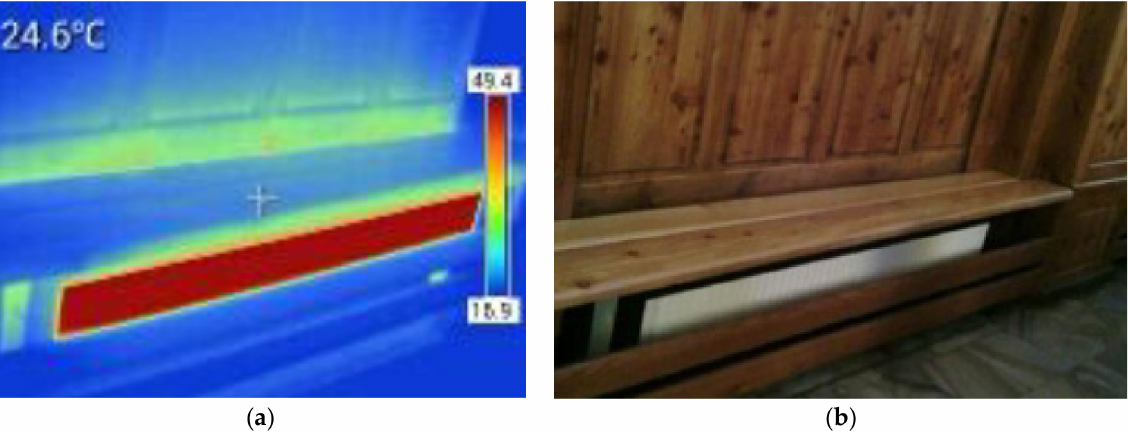
Figure 7. ( a ) Photographs from the KT-165 camera showing heaters under the side benches: thermal image, ( b ) Pictures from the KT-165 camera showing heaters under the side benches: RGB